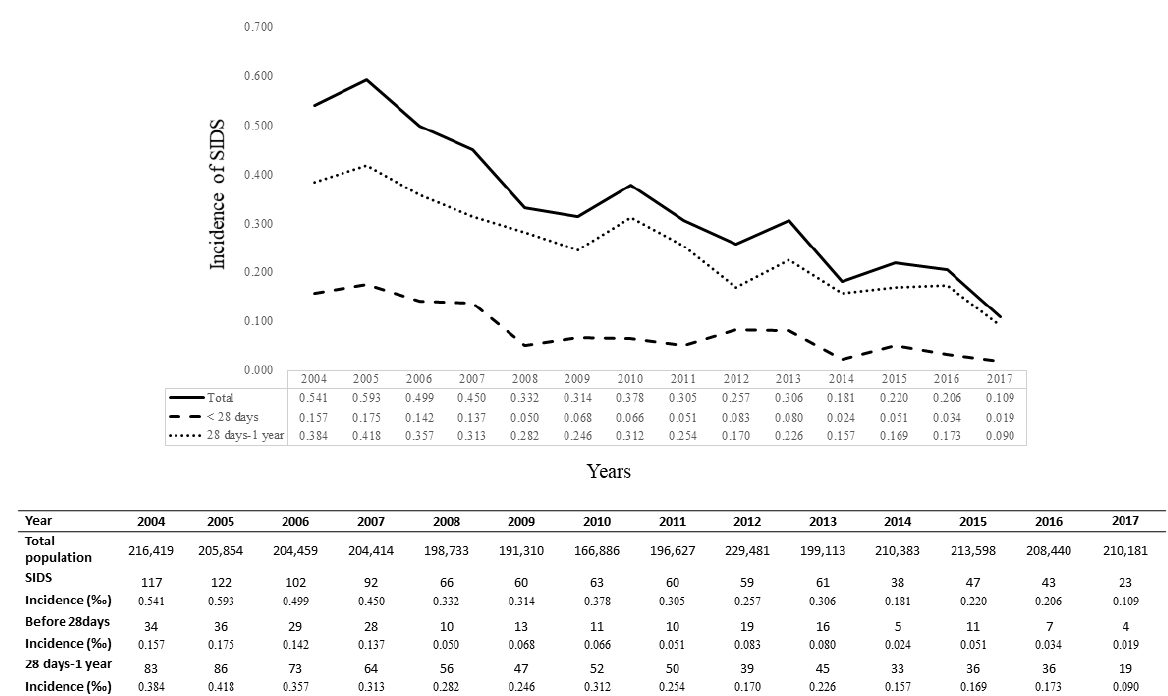
Figure 2. Sudden infant death syndrome (SIDS) population and the incidence of SIDS in Taiwan between 2004 to 2017.